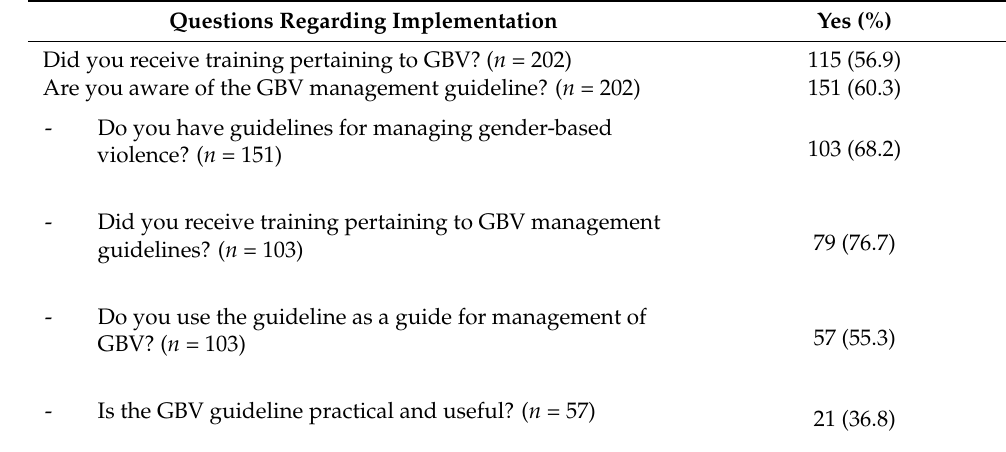
Table 4. Questions regarding implementation.